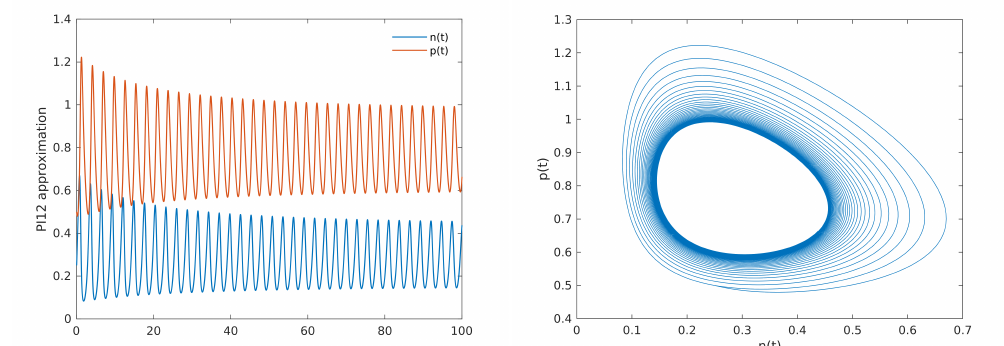
Figure 5. Numerical approximation PI12 of the solutions of system (3) confirming the Hopf instability predicted by the theory in case θ = 0.92 with σ = 3, α = 3.5, k = 5. In the left panel, the trajectories for both variables are reported as functions of time; the right panel shows the limit cycle in the phase